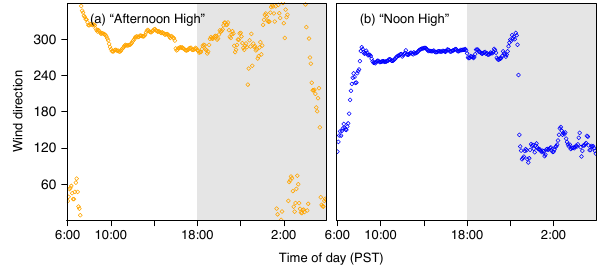
Fig. B1. See list of figure captions. Fig. B1. Vector-averaged diurnal cycles of wind direction (0 de- gree indicates wind coming from north) divided into (a) “Afternoon High” and (b) “Noon High” types. Shaded areas indicate nighttime